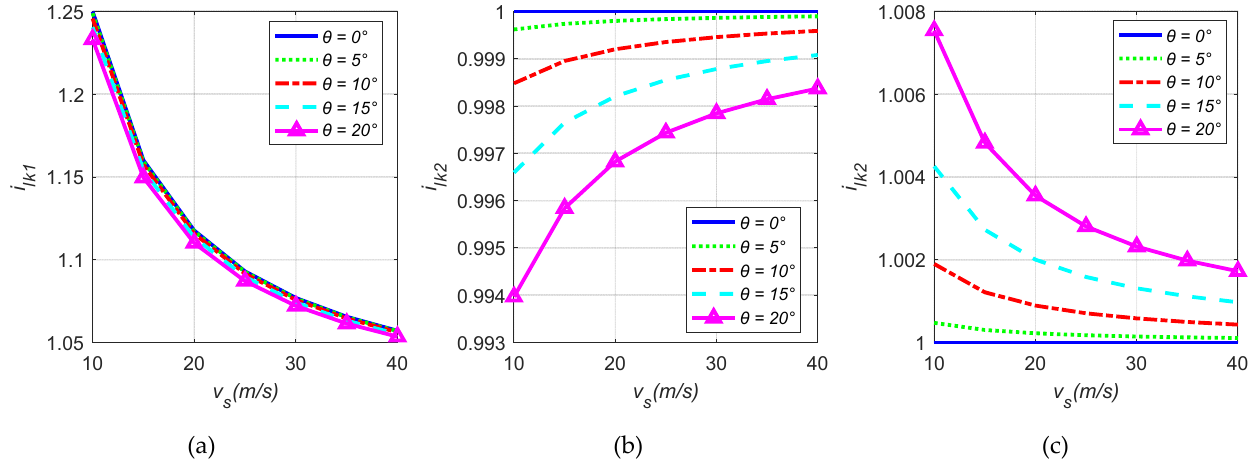
Figure 7. Effects of v s and θ on 𝑖 (cid:3039)(cid:3038)(cid:2869) and 𝑖 (cid:3039)(cid:3038)(cid:2870) : ( a ) effects of v s and θ on 𝑖 (cid:3039)(cid:3038)(cid:2869) ; ( b ) effects of v s and θ on 𝑖 (cid:3039)(cid:3038)(cid:2870) in up-grinding; ( c ) effects of v s and θ on 𝑖 (cid:3039)(cid:3038)(cid:2870) in down-grinding.